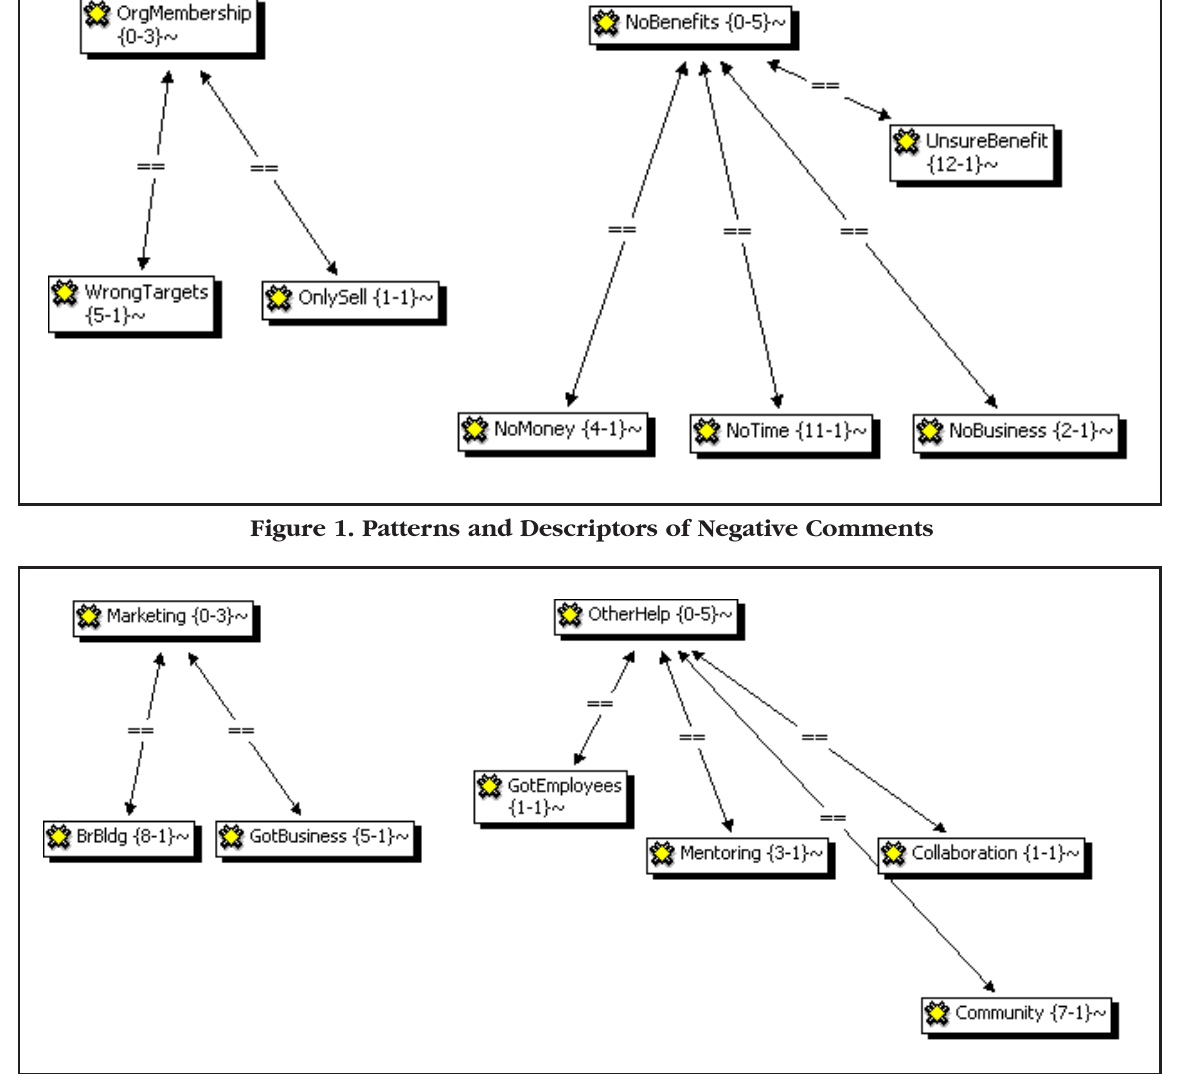
Figure 2. Patterns and Descriptors of Positive